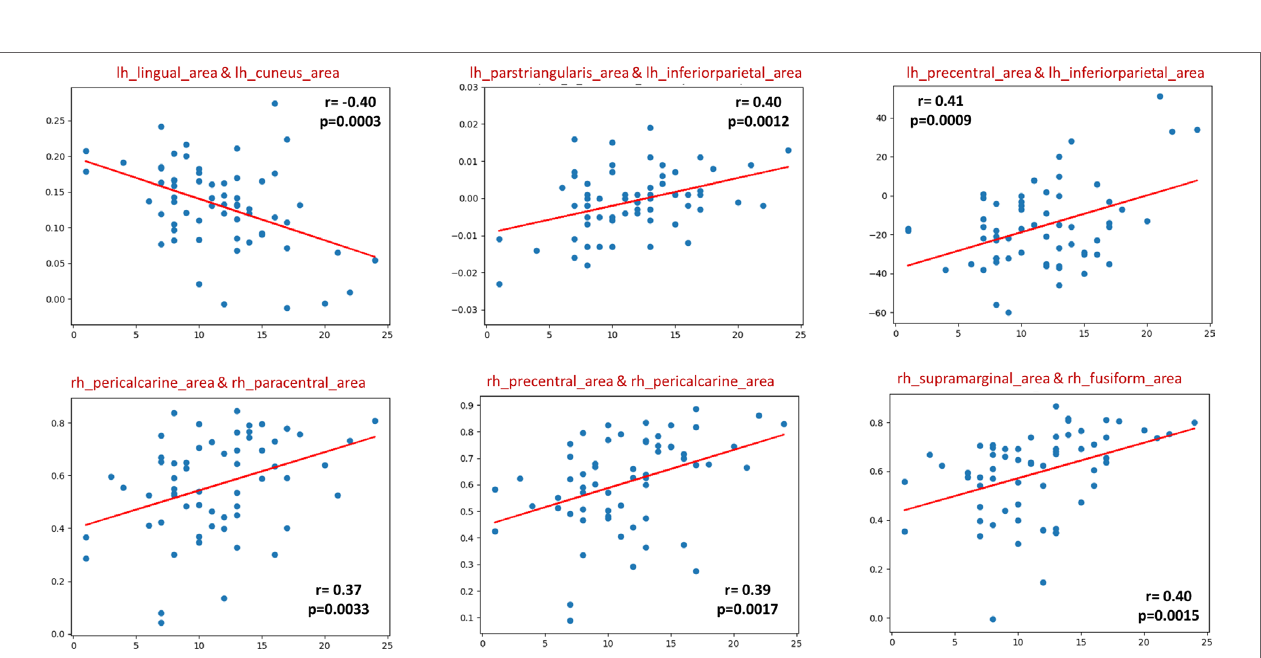
FIGURE 7 | Six selected samples to show the correlation between the feature values in sMRI (upper row), fMRI (lower row), and the ADOS overall score. For each subplot, the figure title shows the couple of area numbers in the DK atlas, the feature name in the case of sMRI, the correlation coefficient, and the P